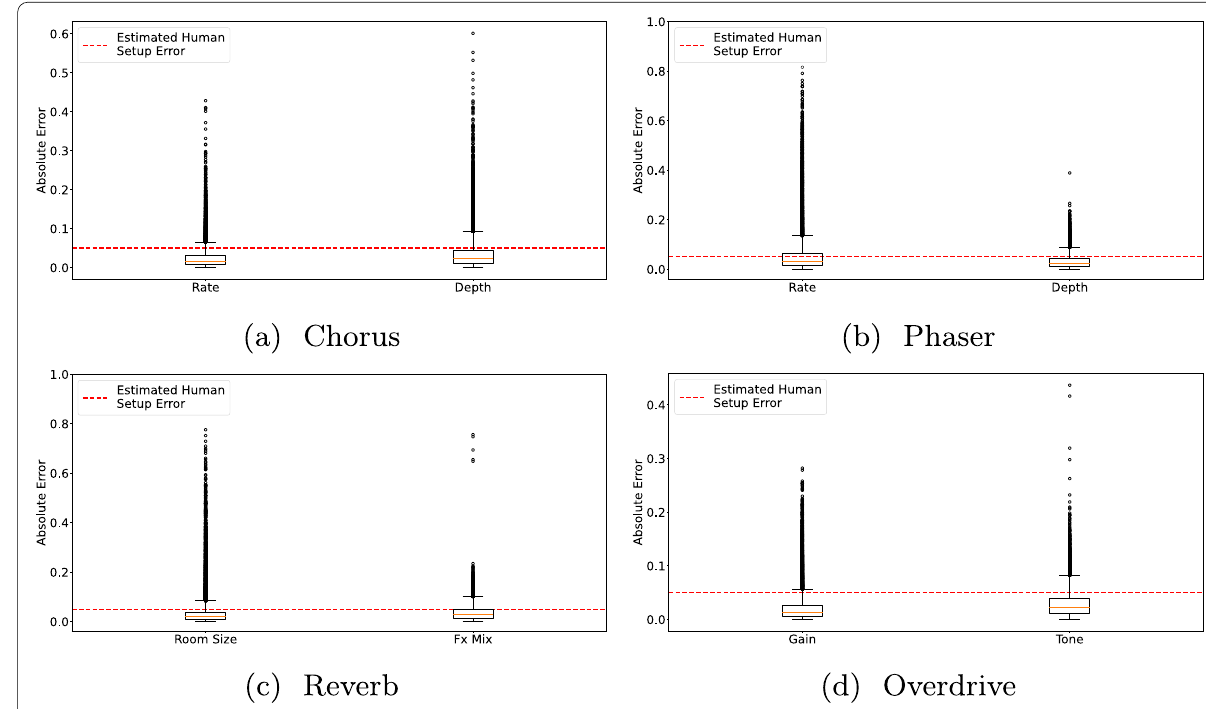
Fig. 11 Boxplots of the absolute error of the parameter extraction using the convolutional neural network with mel-frequency cepstral coefficients for the a chorus, b phaser, c reverb, and d overdrive effect